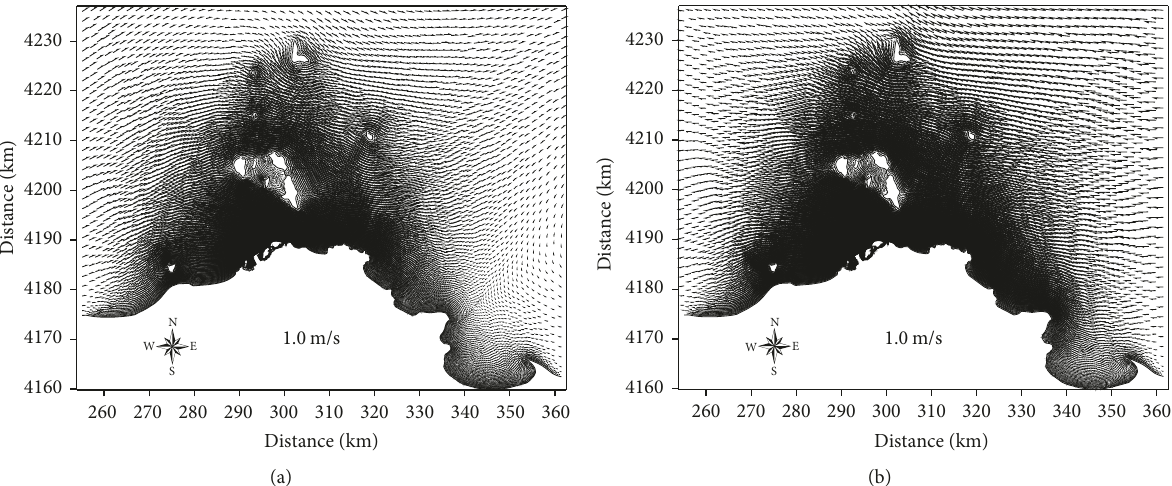
Figure 12: Distributions of the flow field at the times of ebb (a) and flood